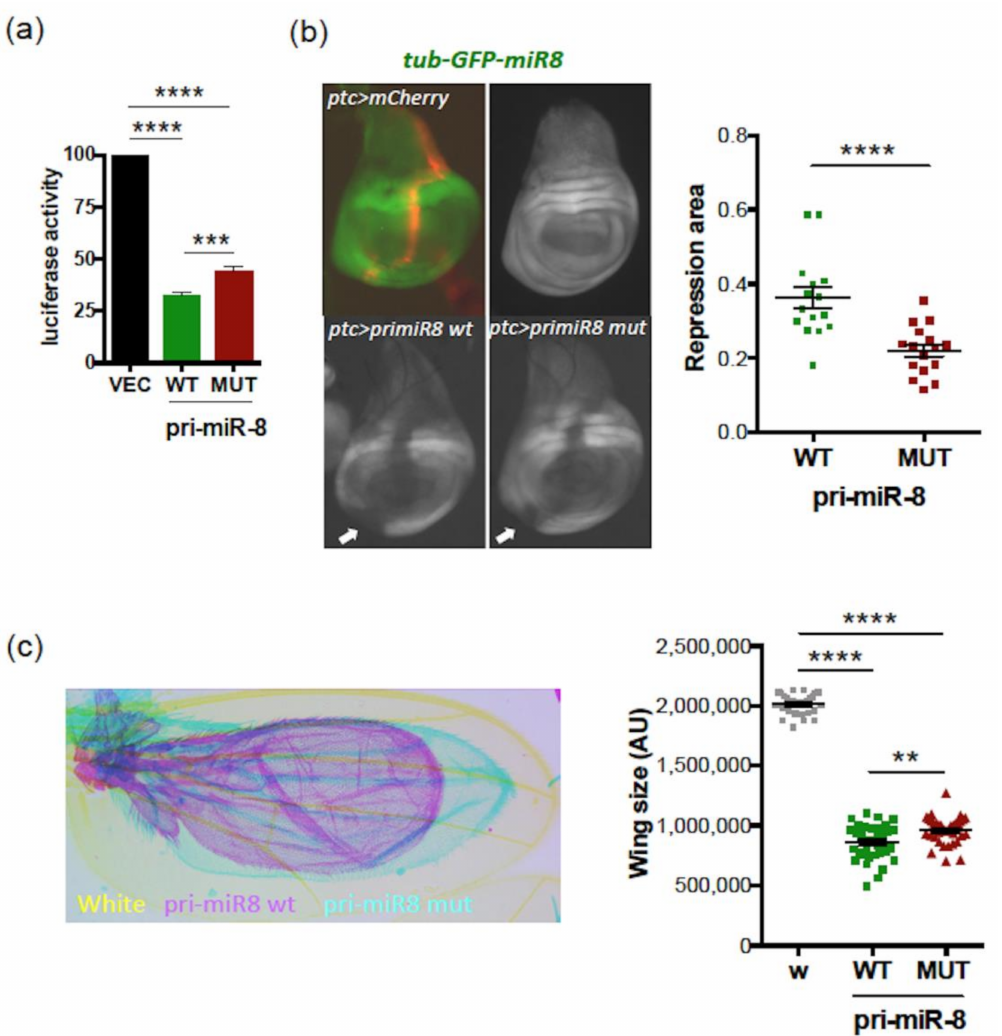
Figure 5. The smORF213 regulates the activity of Drosophila pri-miR-8/miR-8. ( a ) Relative activity of miR-8 processed from the WT or MUT pri-miR-8 constructs transfected in S2 cells together with a miR-8 luciferase sensor. Cells were tested 48h post-transfection for dual luciferase assays. The luciferase activities of pri-miR-8 transfected cells were compared to that of control vector transfected cells (VEC), set to 100. Data are means ± S.E.M. n = 8. ( b ) Activity of miR-8 processed from the WT or MUT pri-miR-8 in wings imaginal discs. Left panel: representative discs are shown, the pri-miR-8 are expressed under the patched ( ptc ) GAL4 promoter and the miR-8 activity is detected with a tubulin GFP miR-8 sensor expressed in wing imaginal discs. The ptc domain is visualized with mCherry. Right panel: quantification of the repression area (indicated by white arrows in the left panel). Data are means ± S.E.M. from 15 wing discs analyzed for WT pri-miR-8 and 16 for MUT. ( c ) Activity of WT or MUT pri-miR-8 on wing size. The WT or MUT pri-miR-8 constructs were expressed in wings using the MS1096 driver and the phenotypes scored on wing size. Left panel: representative wings are shown. Right panel: quantification of the wing size. AU: Arbitrary Units. Data are means ± S.E.M. from 29 wings analyzed for control (white, w), 34 for WT pri-miR-8 and 35 for MUT. ** p < 0.01, *** p < 0.001, **** p <